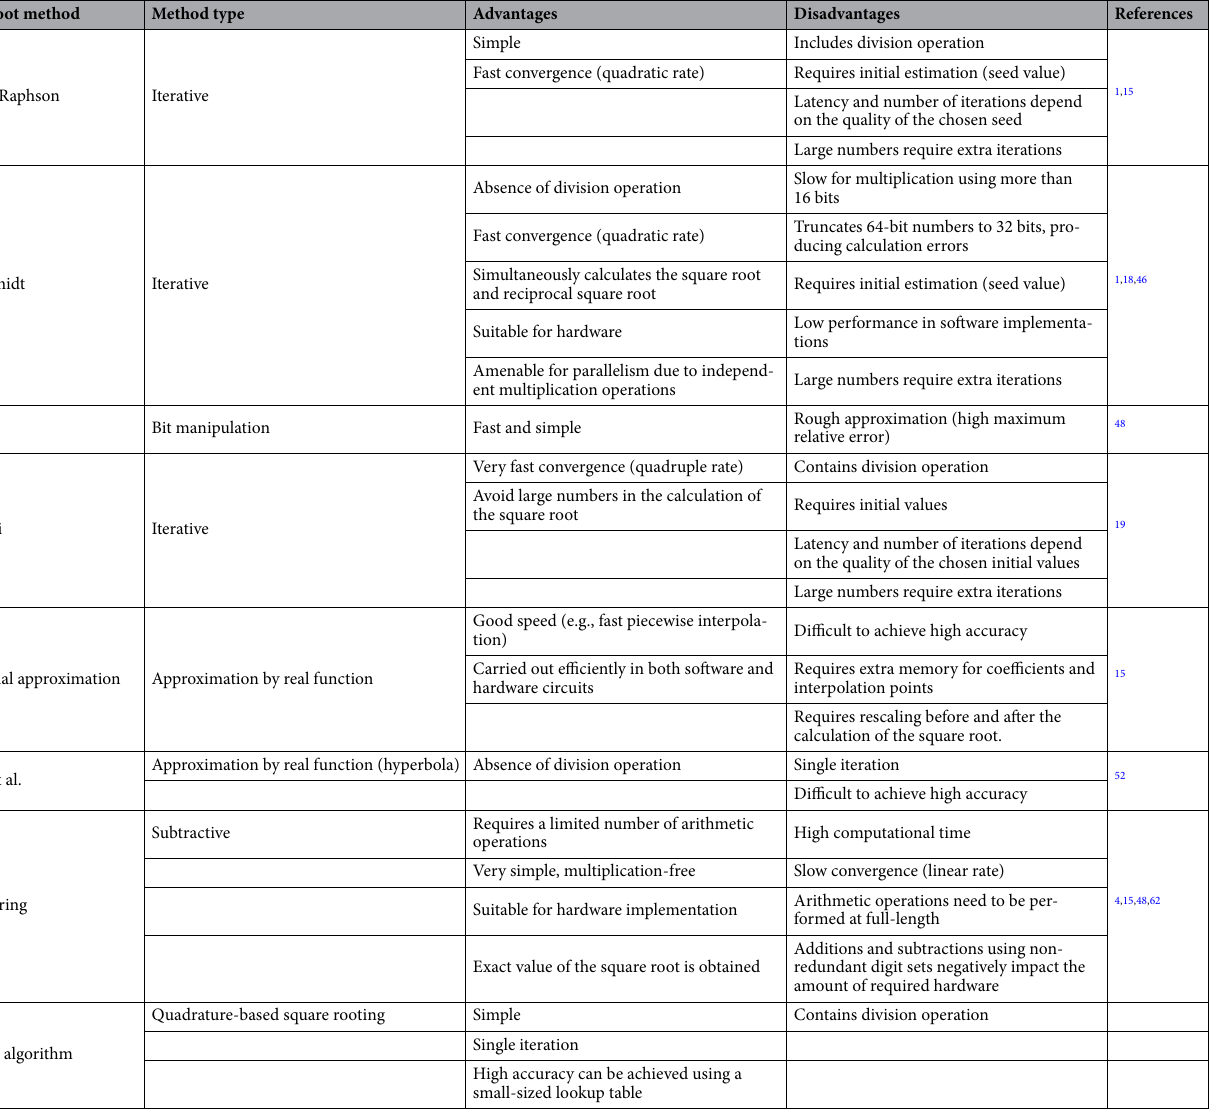
Table 3. Characteristics of selected square root methods and our proposed